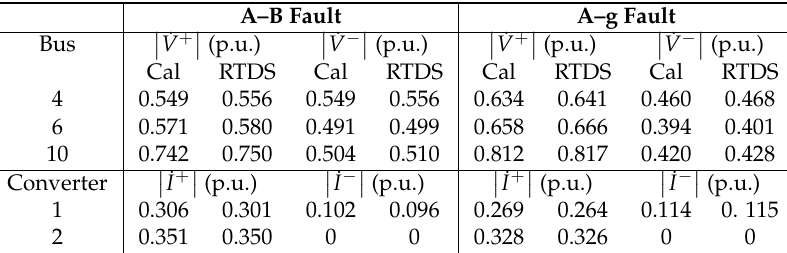
Table 4. Comparison between calculations and simulations (S3).